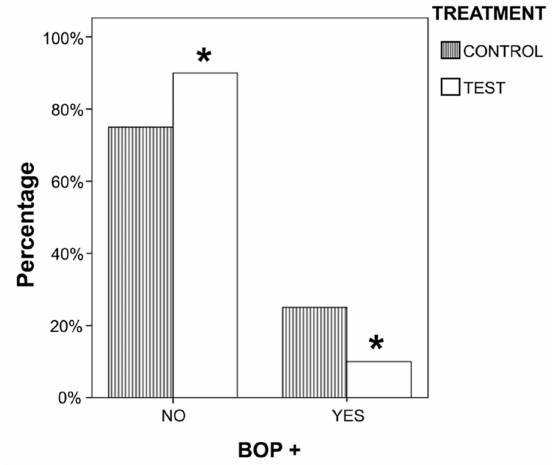
Figure 3. Levels of bleeding on probing positive (BOP+) both groups after 1 month. No bleeding (BOP) was statistically significant in the test group. * p <